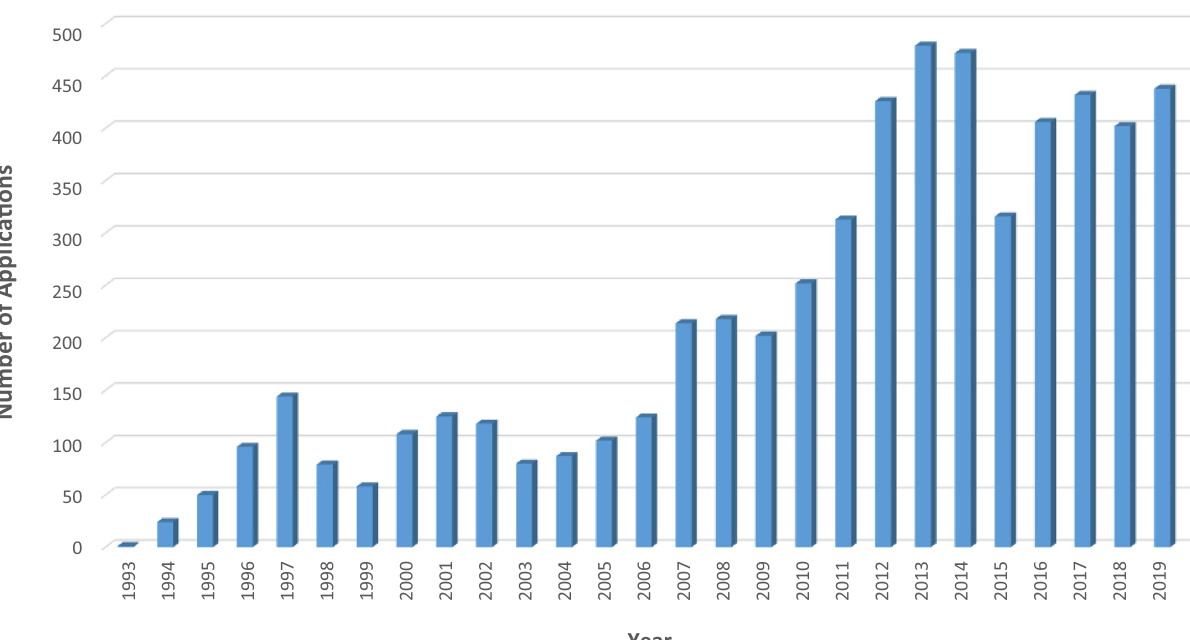
Figure 1: The yearly distribution of EIA applications in Turkey [ 16 ]